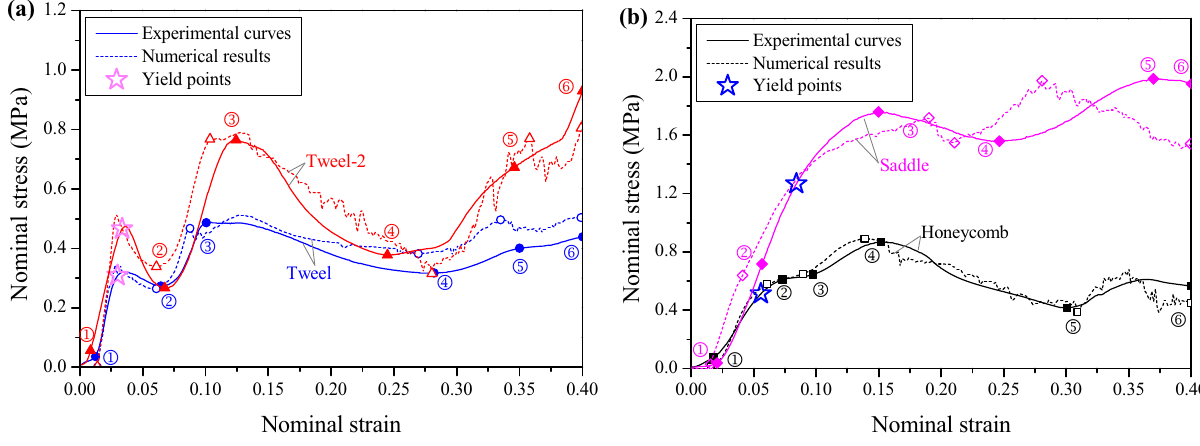
Figure 4: Nominal stress – strain curves of nonpneumatic ( a ) Tweel and Tweel - 2; ( b ) honeycomb and saddle tire samples under quasi - static uniaxial